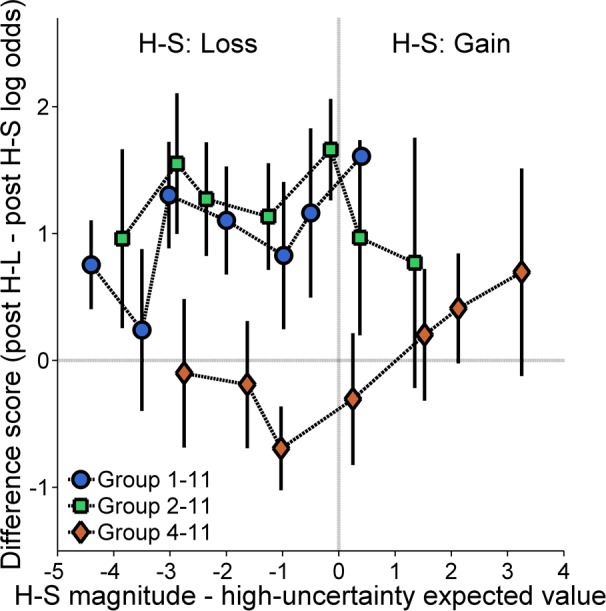
Mean (±SEM) difference score between the log odds of high-uncertainty choices following high-uncertainty-large (H-L) outcomes and the log odds of high-uncertainty choices following high-uncertainty-small (H-S) outcomes for each group in Experiment 1 as a function of the difference between the magnitude of the H-S outcome and the expected value of the high-uncertainty choice.A negative/positive difference on the abscissa indicates that the H-S outcome magnitude was greater than/less than the expected value of the high-uncertainty choice (gain/loss, respectively). A negative or positive difference on the ordinate reflects a greater likelihood to make high-uncertainty choices following H-S or H-L outcomes, respectively.